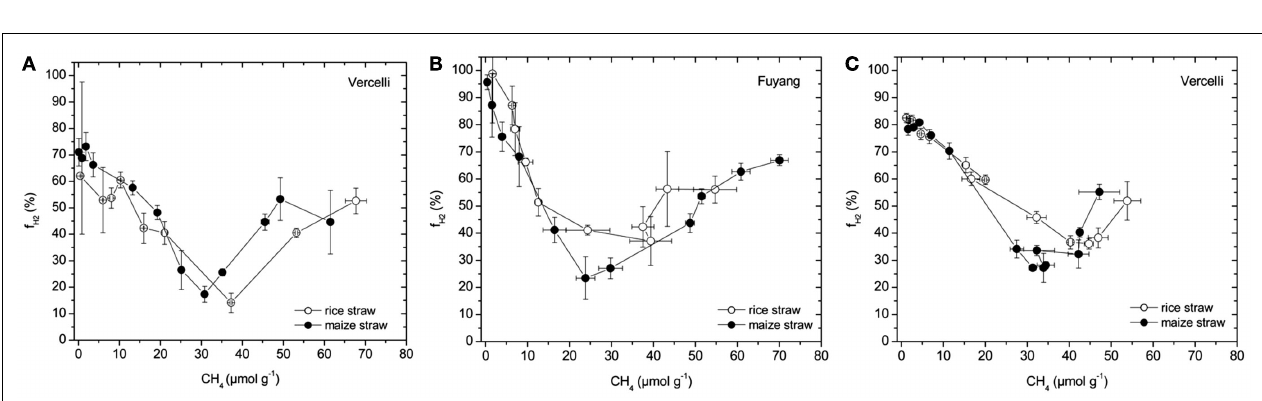
FIGURE 7 | Percentage of CH 4 produced from H 2 /CO 2 ( f H ) in soil from (A)Vercelli, (B) Fuyang, and (C) Suwan, amended with either rice straw or maize 2 straw, as calculated using Equation 4, and the data shown in Figures 4 and 5.